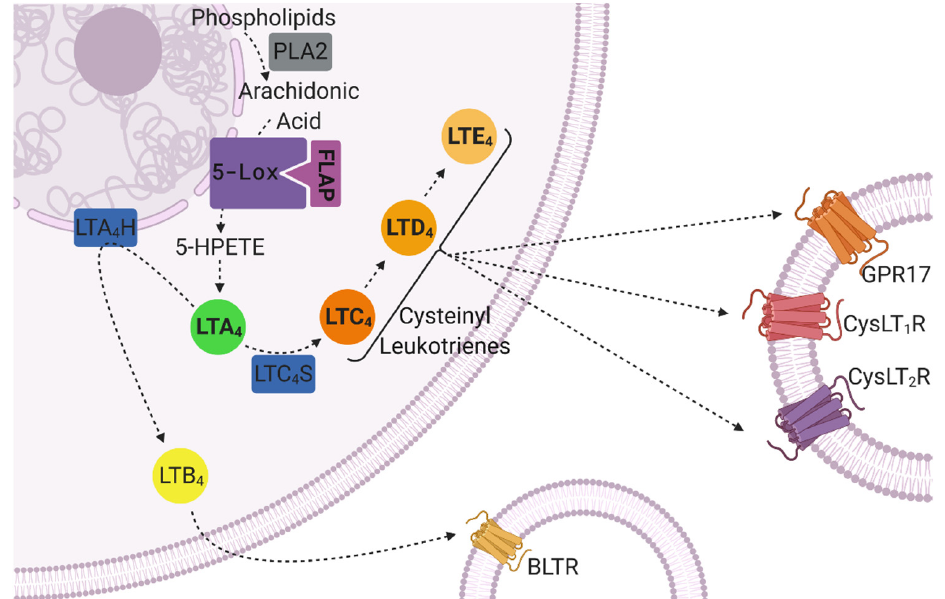
Figure 3. The leukotriene biosynthesis and signaling pathway. Leukotrienes derive from arachidonic acid, which is cleaved from membrane phospholipids by phospholipase A2 (PLA2) and further processed by the key enzyme 5-lipoxygenase (5-Lox) and its activator, 5-lipoxygenase activating protein (FLAP). The intermediate product 5-hydroperoxyeicosatetraenoic acid (5-HPETE) gives rise to leukotriene A 4 (LTA 4 ), which is further converted to leukotriene B 4 (LTB 4 ) by leukotriene A 4 hydrolase (LTA 4 H) or to the cysteinyl leukotrienes leukotriene C 4 , D 4 and E 4 (LTC 4 , LTD 4 and LTE 4 ) by leukotriene C 4 synthase (LTC 4 S). Leukotrienes evoke inflammatory responses by binding with different affinities to specific receptors on target cells. These include the leukotriene B 4 receptor (BLTR), the G-protein-coupled receptor 17 (GPR17), the cysteinyl leukotriene receptor 1 (CysLT 1 R) and cysteinyl leukotriene receptor 2 (CysLT 2 R). Created with BioRender.com (last accessed on 4 November 2021).